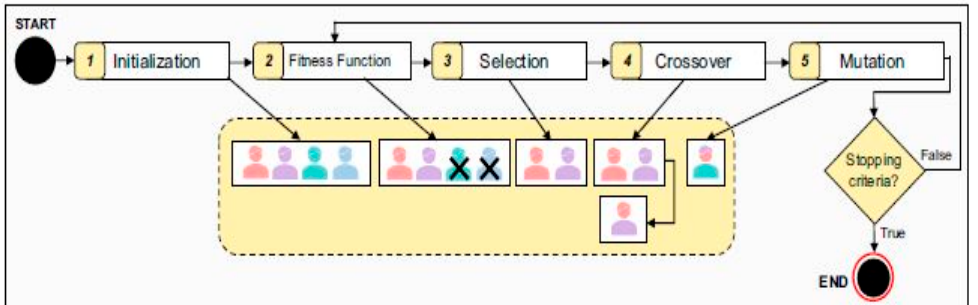
Figure 5. Genetic algorithm [41].